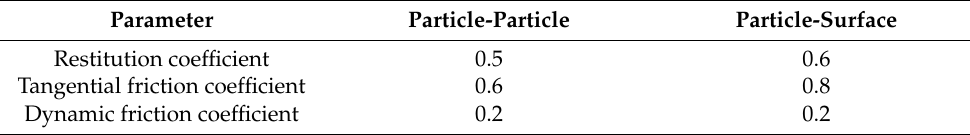
Table 2. Rape grain contact parameters used in the